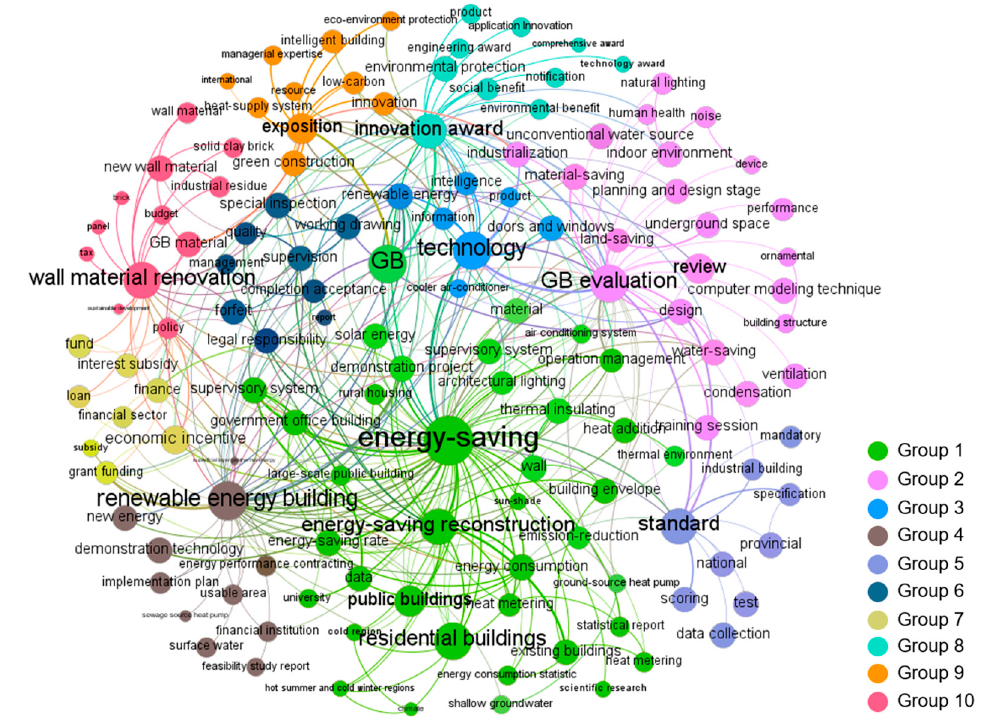
Figure 4. Co-word network of China’s GBPs in stage 3.